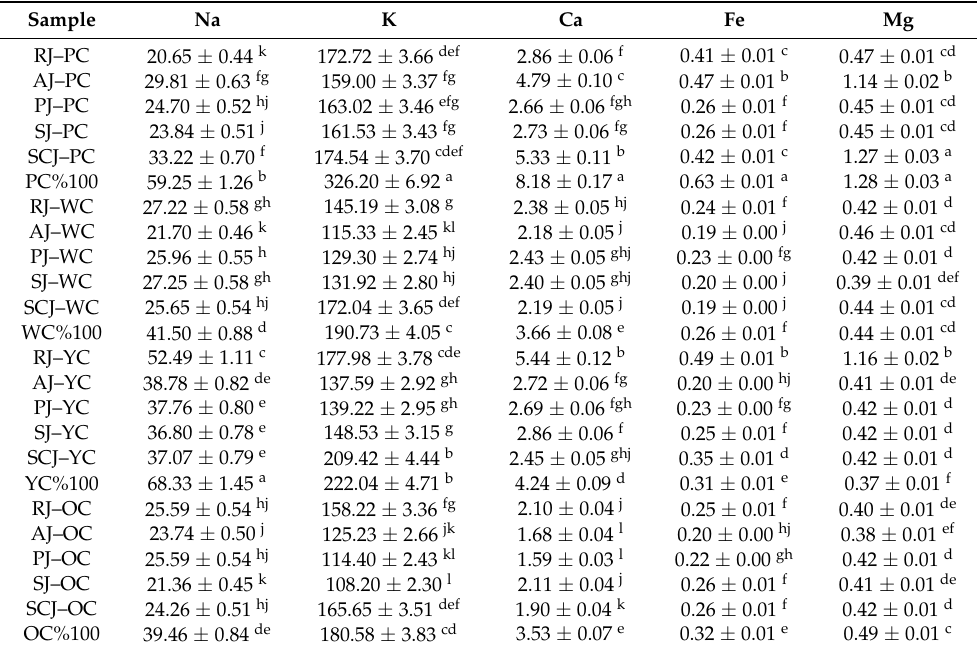
Table 2. The mineral contents of carrot-based